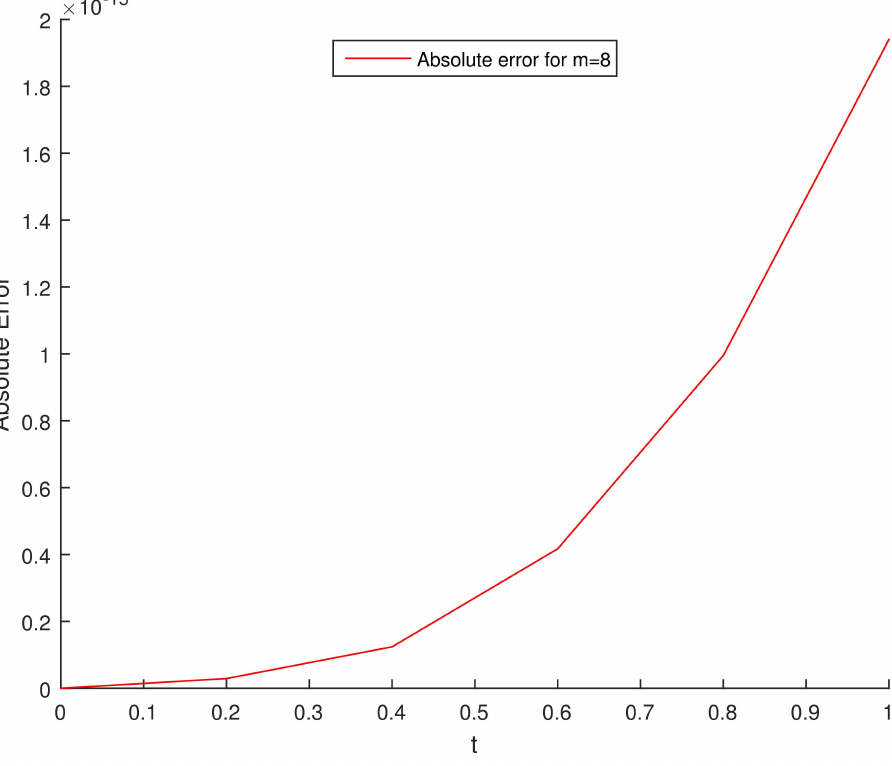
Figure 2. The acquired absolute error of Example 1 for µ = 3 and m = 8.